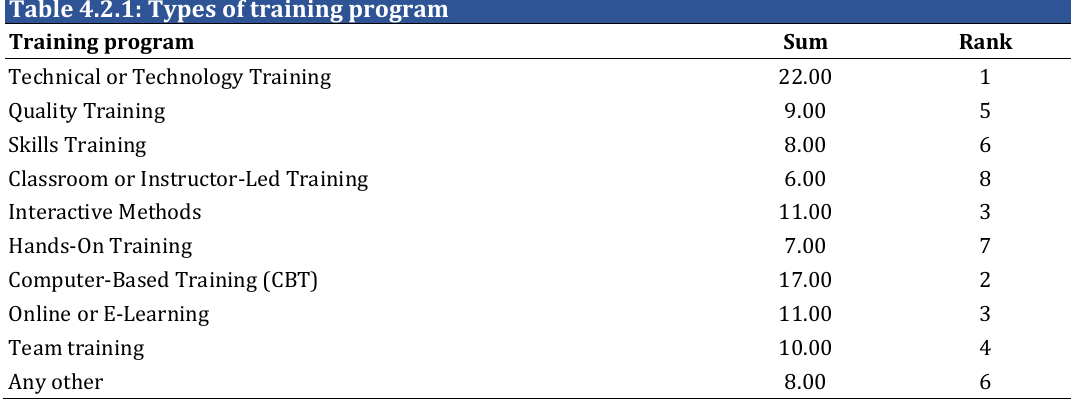
Figure 4.2.1.1: Training